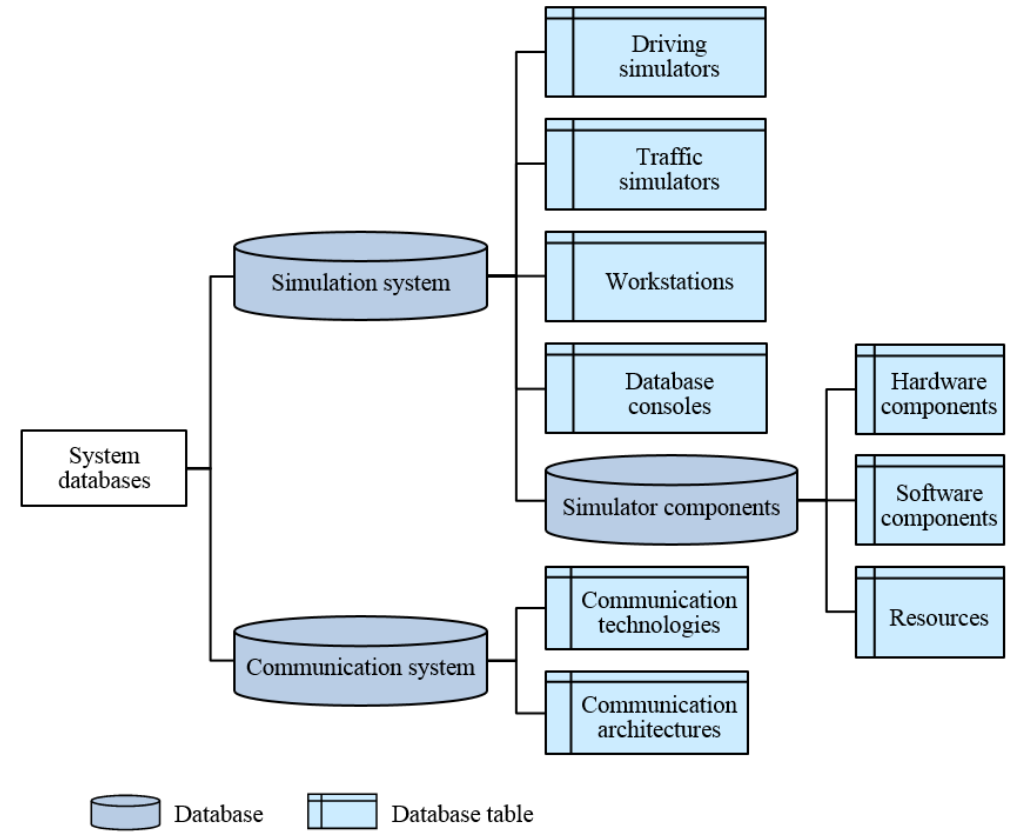
Figure 9. The developed system databases and the main tables.